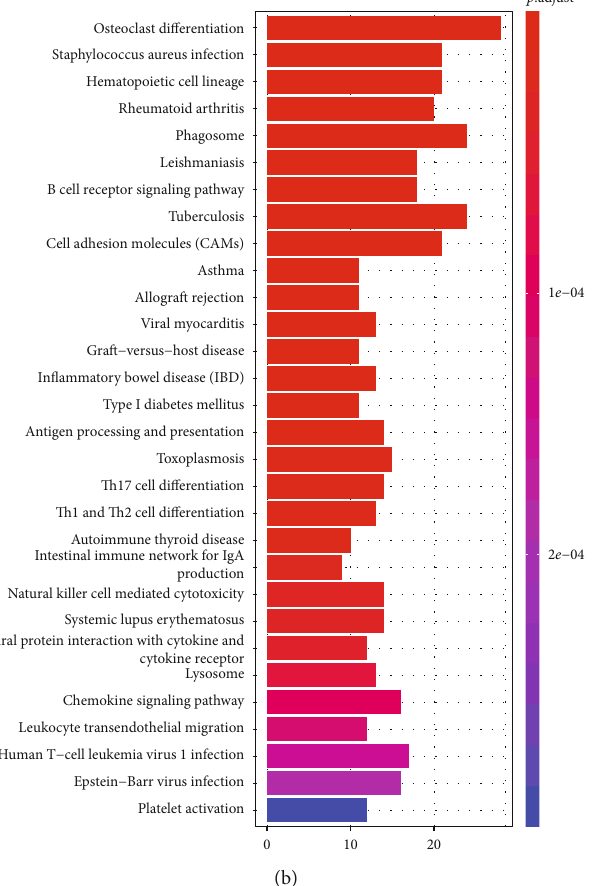
Figure 6: The results of GO and KEGG enrichment analysis in OS. (a) Gene ontology analysis: biological process, cellular component and molecular function of di ff erentially expressed genes, respectively. (b) KEGG analysis: the top 30 signi fi cant pathways of di ff erentially expressed